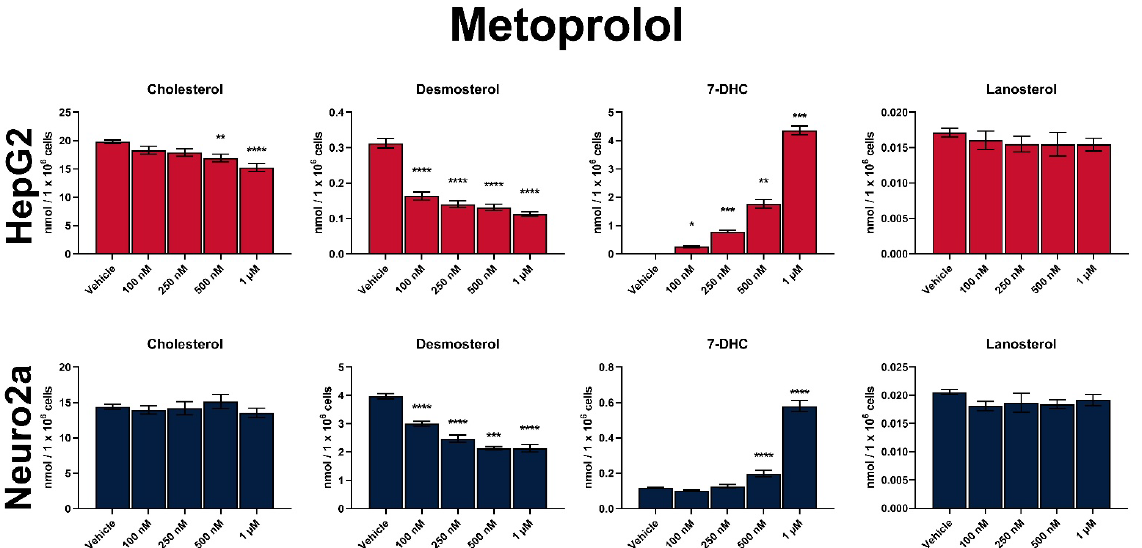
Figure 2. Dose-dependent sterol response of HepG2 and Neuro2a cells treated with MTP. Values reported as nmol/million cells. Statistical significance: * p < 0.05; ** p < 0.01; *** p < 0.001; **** p < 0.0001 vs. vehicle treatment.